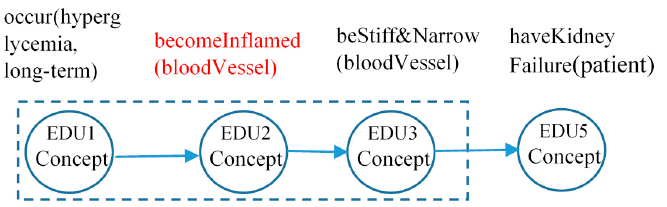
Figure 3. Show a causal pathway expression (EDU1, EDU2, EDU3 and EDU5) of Example